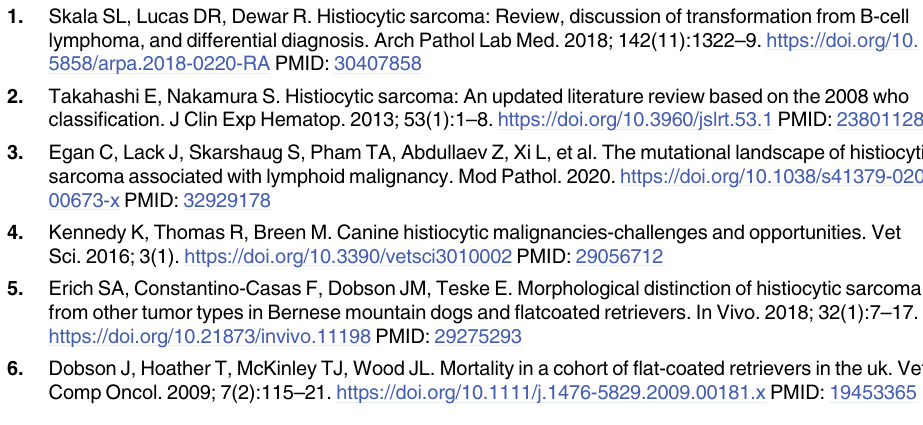
S13 Table. Cohort information. (XLSX) S14 Table. Primer sequences and reaction conditions for variant genotyping.